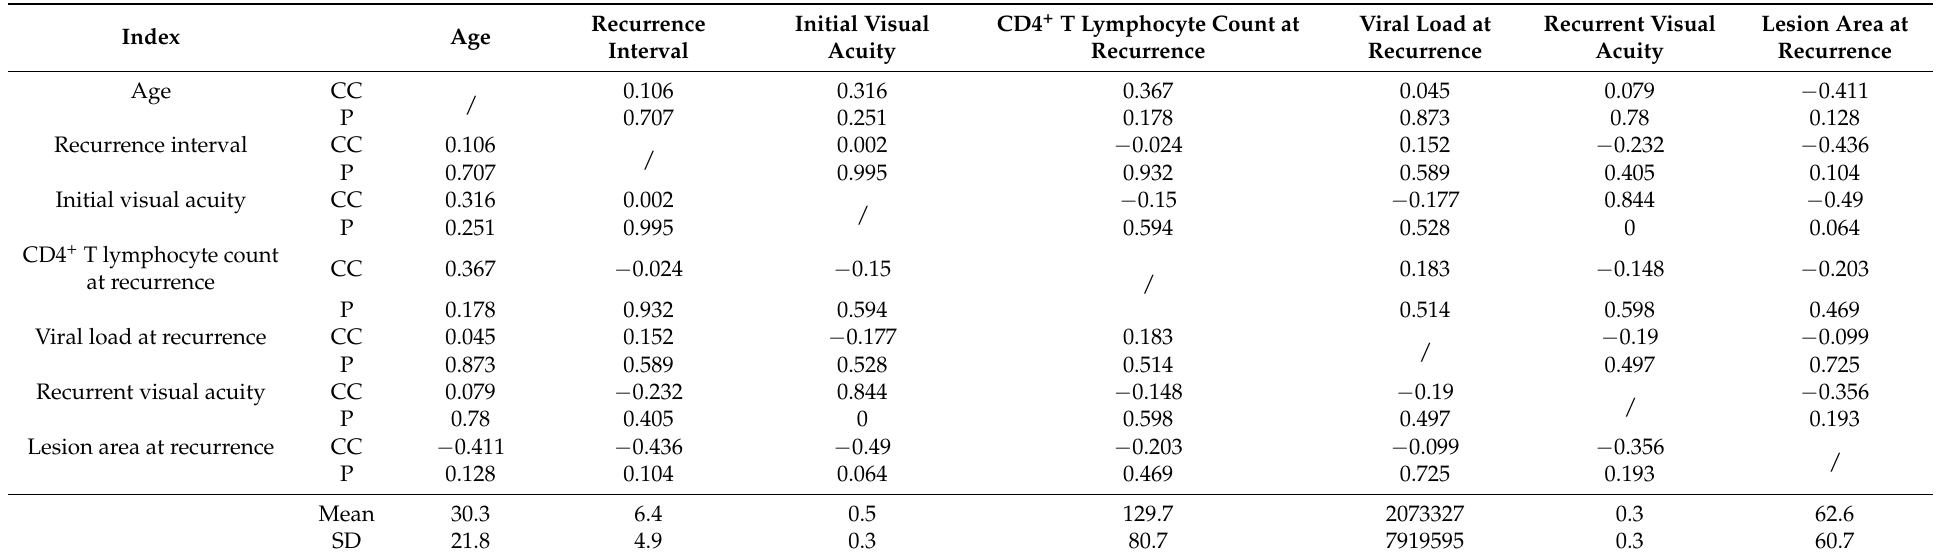
Table 3. Statistical table of clinical data of patients with recurrent CMVR after